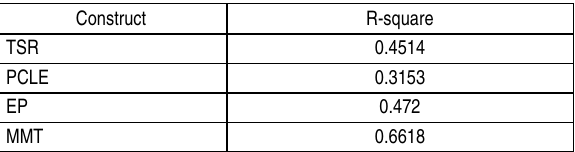
Table 3. Value of R 2 value